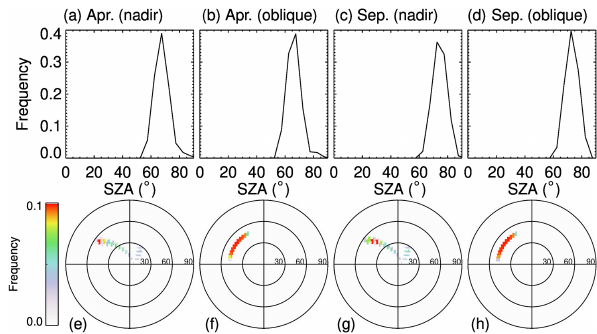
Figure 1. Upper panels are the histograms of SZA for SLSTR ob- servations: (a) nadir during April, (b) oblique during April, (c) nadir during September, and (d) oblique during September. Lower panels are the polar plots of (VZA, RAA) probability for AATSR obser- vations: (e) nadir during April, (f) oblique during April, (g) nadir during September, and (h) oblique during